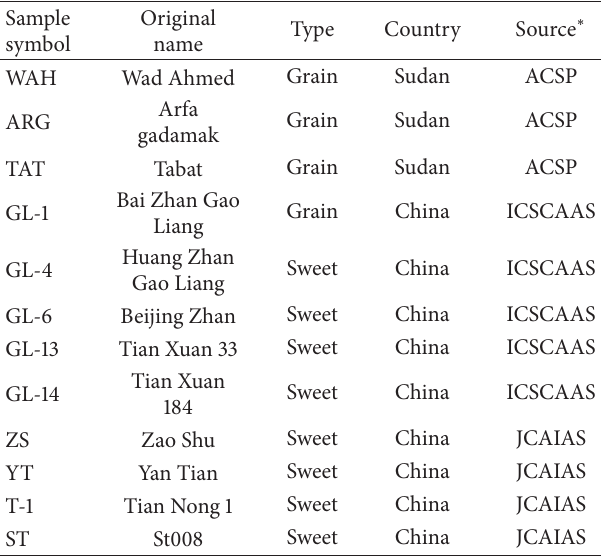
Table 1: The information of sorghum varieties used in this study.